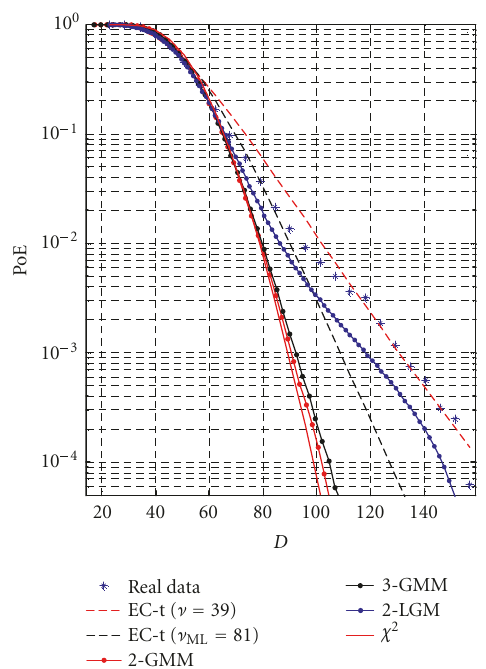
Figure 3: Class no.2 (bare soil) : PoE of D for the real data and for the theoretical models.